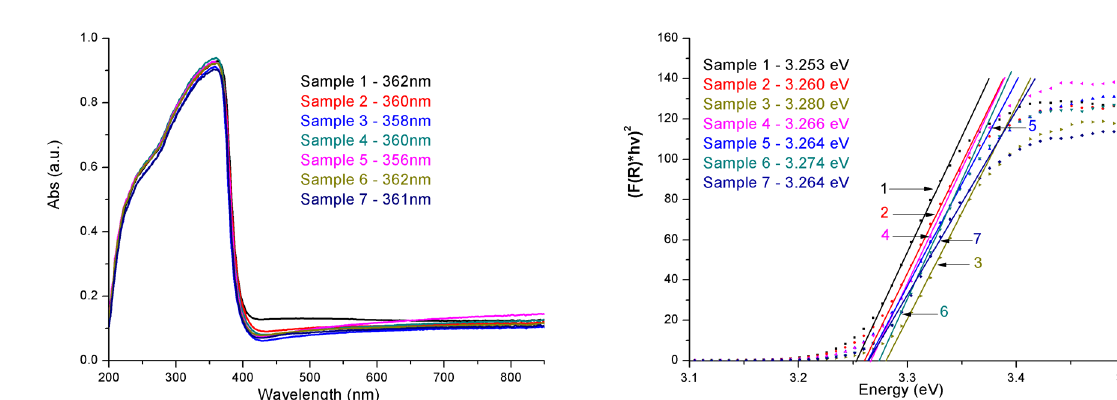
Figure 5. TEM images, SAED patterns and the corresponding HRTEM images for ZnO powders obtained in different media based on ionic liquids – mixture of [emim][BF ] + EG. 4